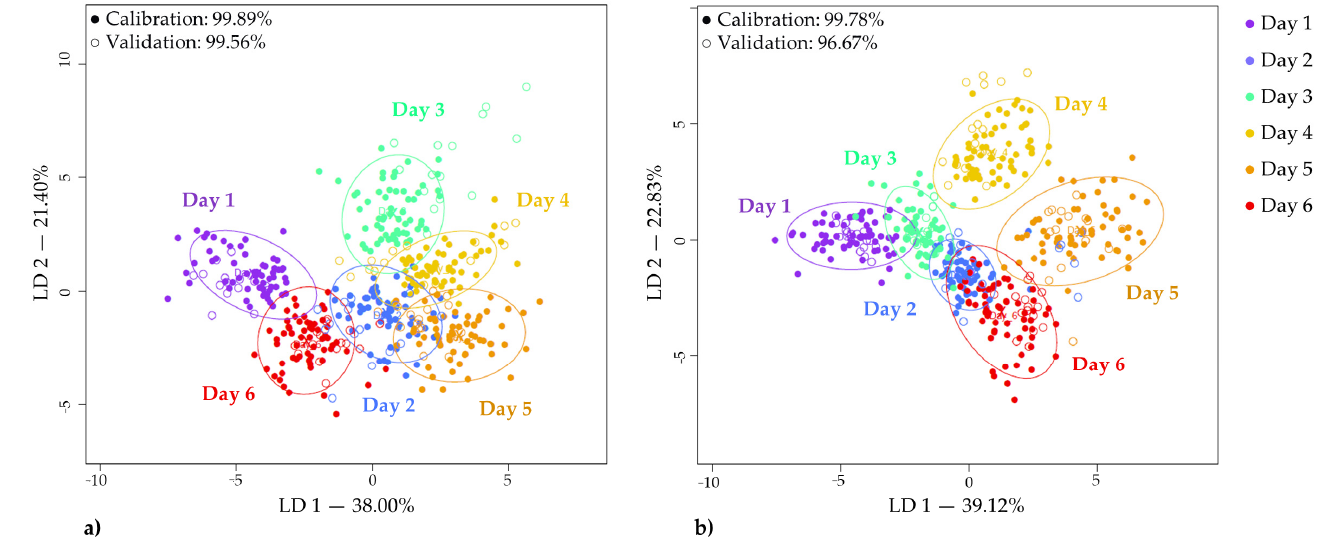
Figure 9. PCA-LDA classification models when “storage time” was the class variable ( a ) on the data of inner leaves (raw spectra, N = 450, NrPCs = 24), and ( b ) on the data of outer leaves (deTr-treated spectra, N = 450, NrPCs = 30). Table 1. PCA-LDA classification results on the data of inner leaves when “storage time” was the class variable (raw spectra, N = 450, NrPCs = 24).